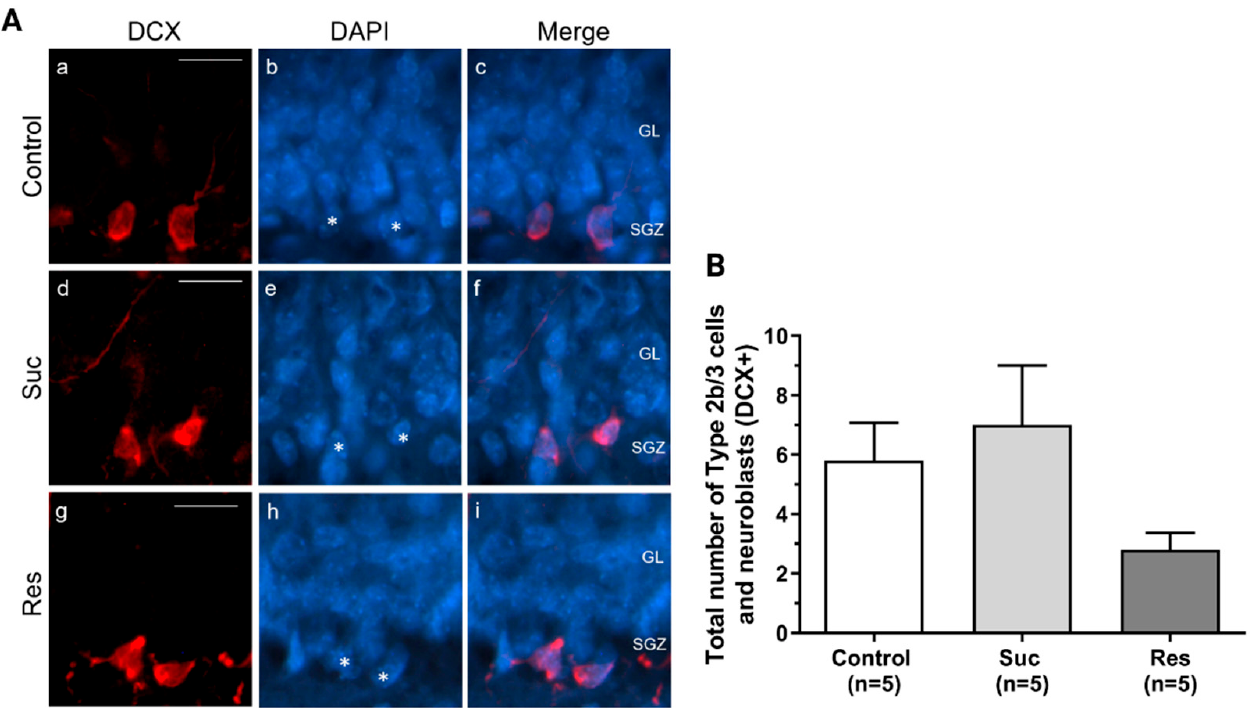
Figure 7. Sucrose consumption does not modify the pool of Type 2b/3 cells and neuroblasts in the subgranular zone of the ventral dentate gyrus. ( A ) Representative photomicrographs showing Type 2b/3 cells and neuroblasts (DCX+, red), and their merge with DAPI (blue) in the subgranular zone (SGZ) of the ventral dentate gyrus (DG) in the control (a–c), Suc (d–f) and Res (g–i) groups. Arrowheads show the cell nuclei (DAPI+) that colocalized with DCX marker. ( B ) A cell counting of Type 2b/3 cells and neuroblasts located in the ventral DG. No significant difference was found. Kruskall Wallis test. GL: granule cell layer. Scale bar: 20 µm.